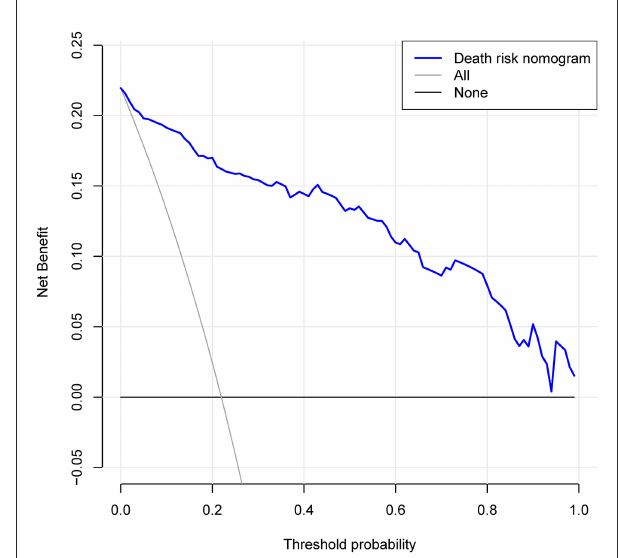
FIGURE6 Decision curve analysis for the risk of in-hospital death nomogram. The y-axis measures the net benefit. The dotted line represents the risk of hospital death nomogram. The thin solid line represents the assumption that all patients are left alone. Thin thick solid lines indicate no intervention. The decision curve shows that the use of this nomogram to predict the risk of in-hospital death in this study adds more benefit than patients who do not use this model if the threshold probabilities for patients and doctors are 1 and 99%